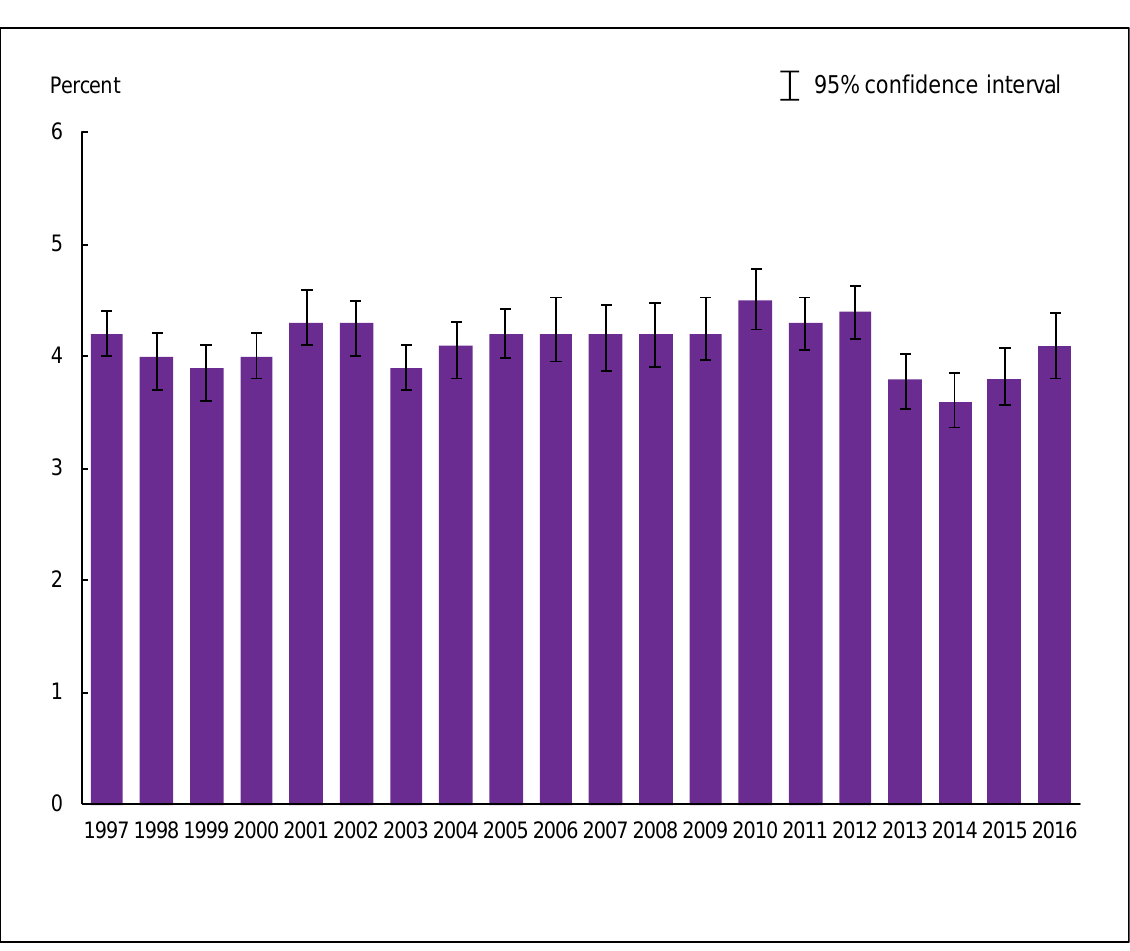
Figure 15.1. Percentage of persons of all ages who experienced an asthma Asthma episode in the past 12 months: United States,